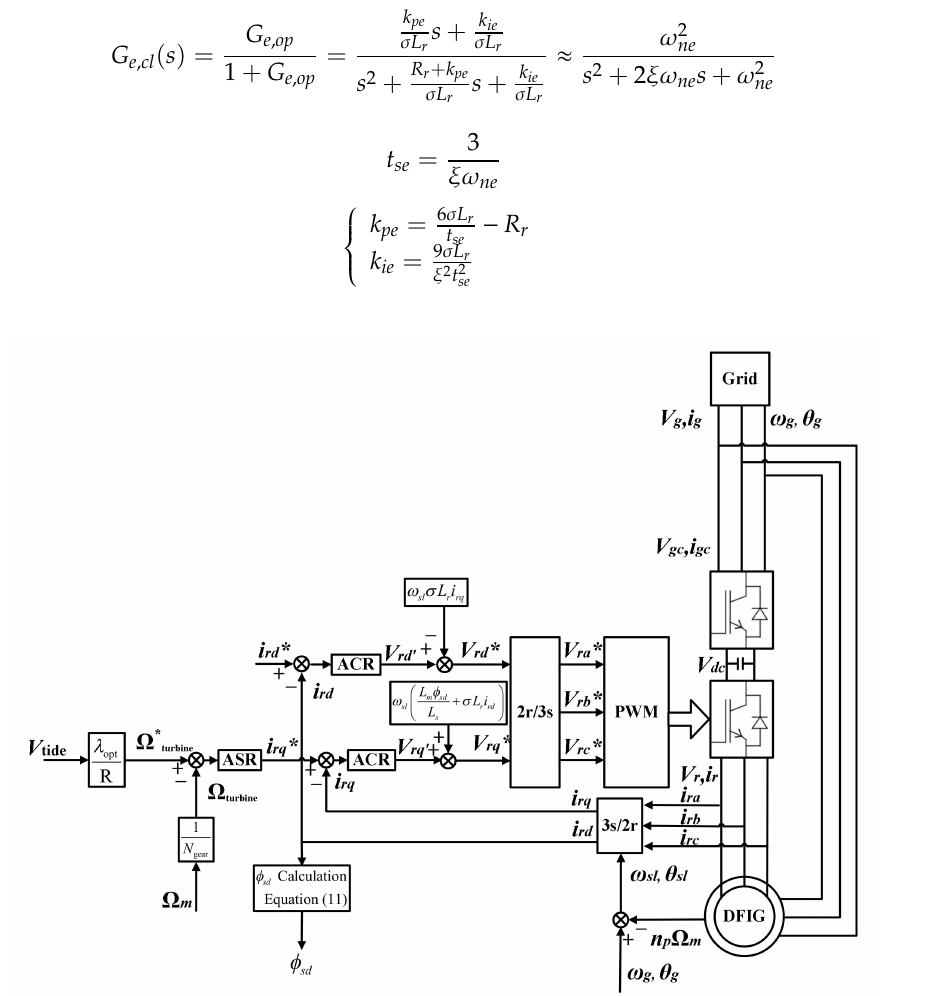
Figure 3. Diagram of torque-speed control strategy of